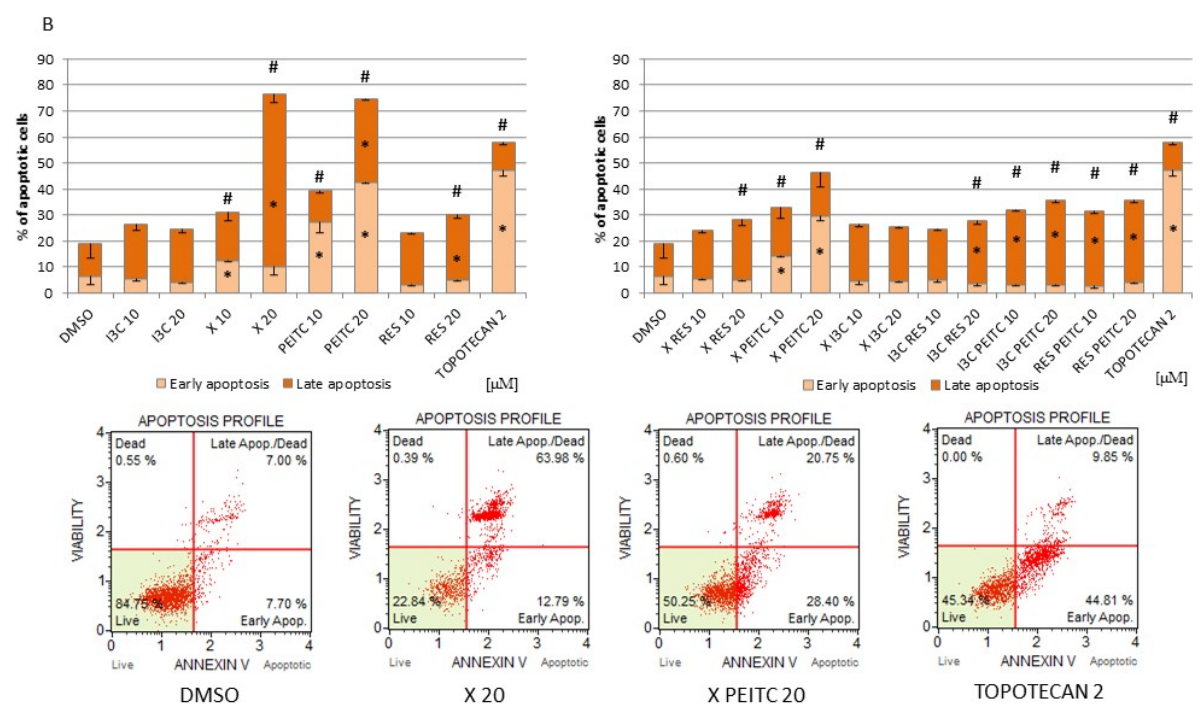
Figure 11. The impact of X, PEITC, RES, I3C, and their mixtures on cell cycle distribution and induction of apoptosis in HepG2 cells. Panel ( A ) The percentage of cells in G1/G0, S and G2/M phase analyzed by the flow cytometry after staining with propidium iodide and RNase A. Panel ( B ) The percentage of cells in the early and late stage of the apoptosis evaluated by the flow cytometry measurements based on fluorescence signal from Annexin V bound to phosphatidylserine externalized in apoptotic cells and a dead cell marker 7-AAD. Topotecan was used as a reference for cell cycle arrest ( A ) and pro-apoptotic activity ( B ). Exemplary plots are presented. Results were calculated from three separate experiments (mean ± SEM). (*) above the bar indicates statistically significant differences from the control group, while hashes (#) indicate statistically significant changes in the percentage of total apoptotic cells, p < 0.05.